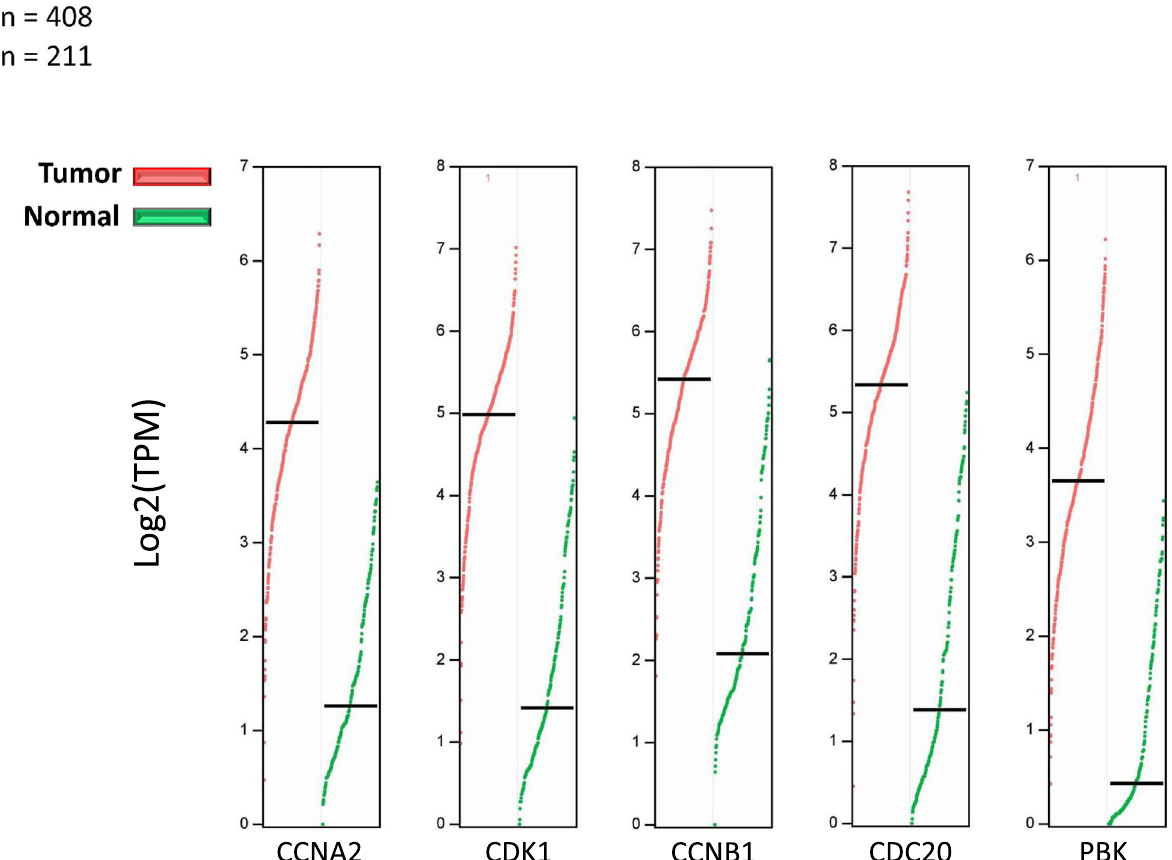
Fig. 5 Expression profiling of the hub genes. Data were firstly TPM normalized and then log2 transformed. The median for all the hub genes in gastric tumor samples was larger than in normal